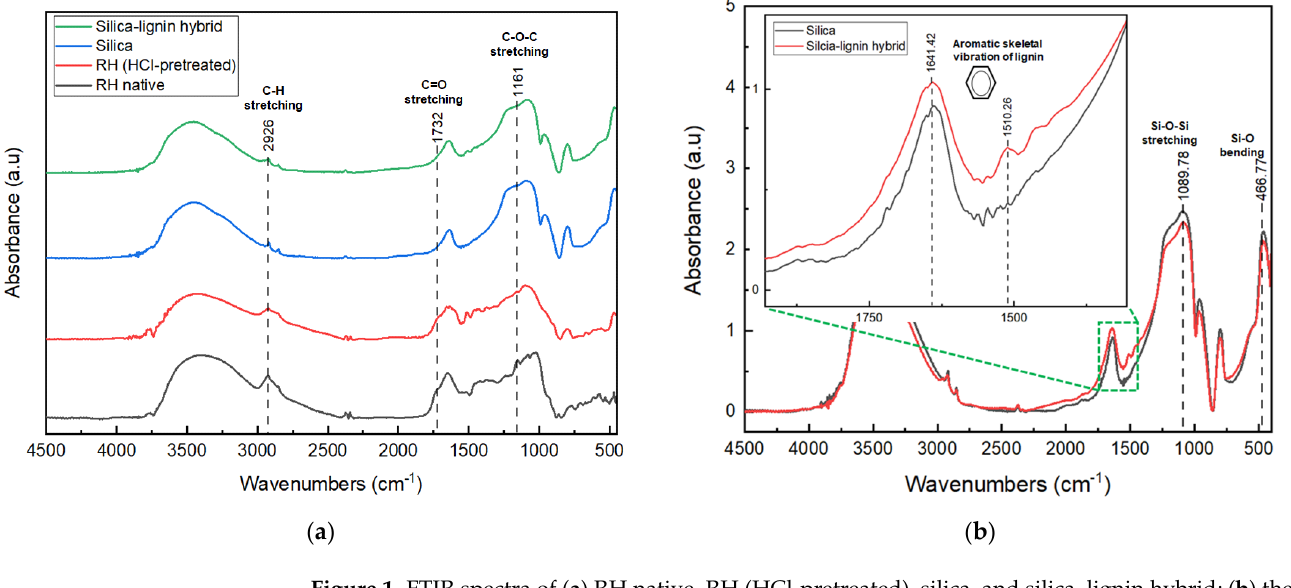
Figure 1. FTIR spectra of ( a ) RH native, RH (HCl-pretreated), silica, and silica–lignin hybrid; ( b ) the comparison peak of silica and silica–lignin hybrid.